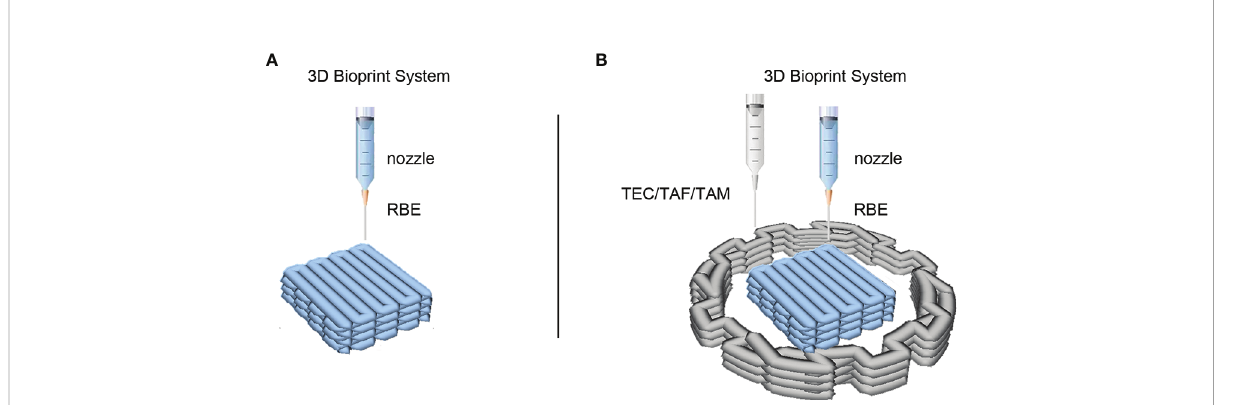
FIGURE 1 3D bioprinted models of cholangiocarcinoma (CCA) immune microenvironment. (A) The schematic of 3D bioprinted model of CCA with RBE alone. (B) The schematic of 3D bioprinted model with CCA cells RBE and stromal cells. The middle square structure in blue represents hydrogel containing RBE cells, while the peripheral structure in grey represents hydrogel containing TEC, TAF, or TAM cells according to different